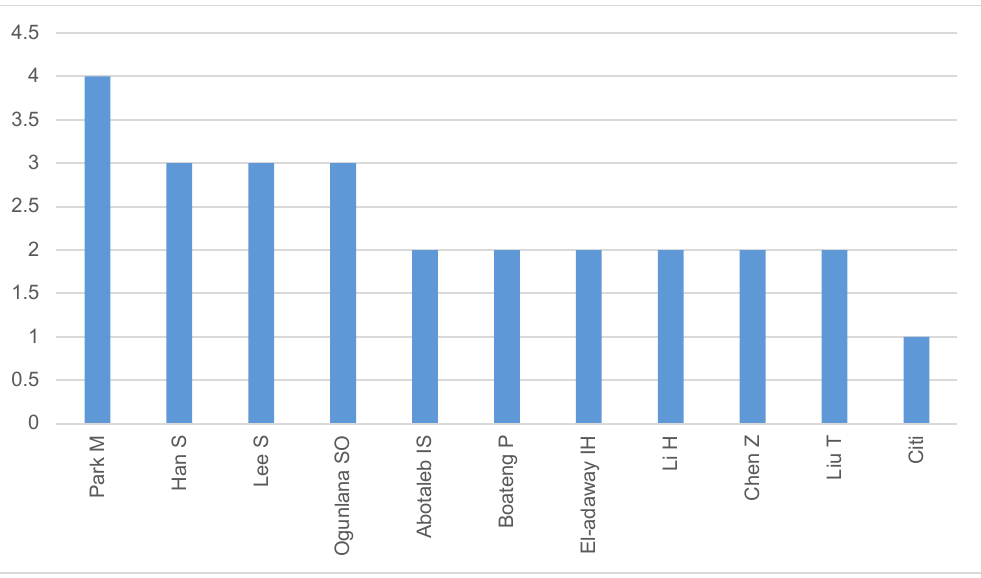
Fig. 6. The largest number of publications prepared by the authors. Source: created by the author based on data from Clarivate